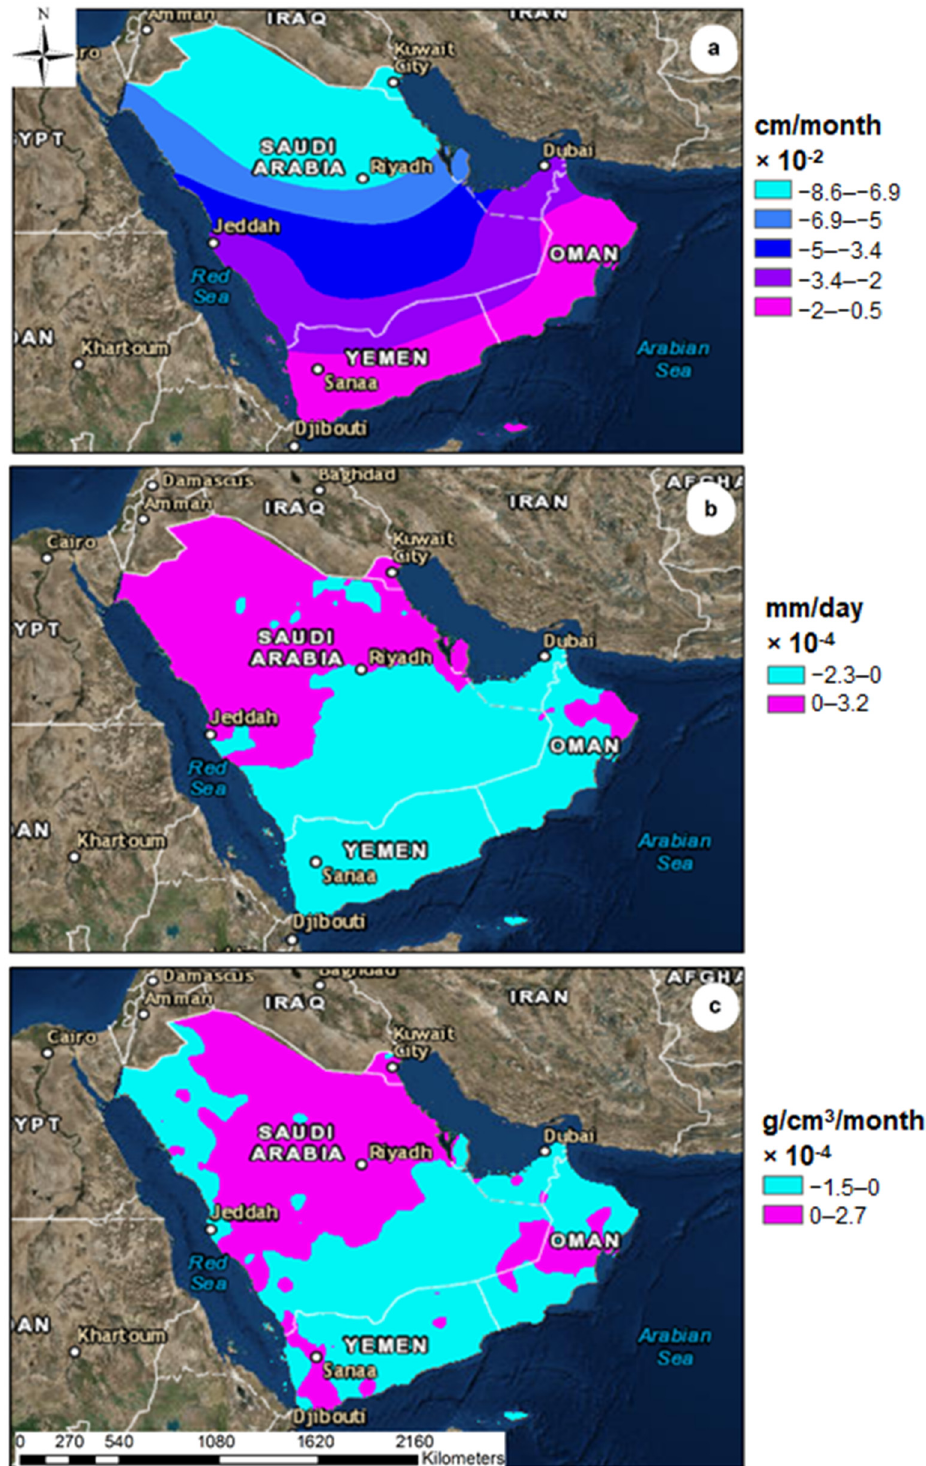
Figure 4. Spatially distributed slopes of linear trends from GRACE ( a ), TRMM ( b ), and AMSR-E ( c ) datasets. Overall negative trend coefficients ranging from − 8.6 × 10 − 2 to − 0.5 × 10 − 2